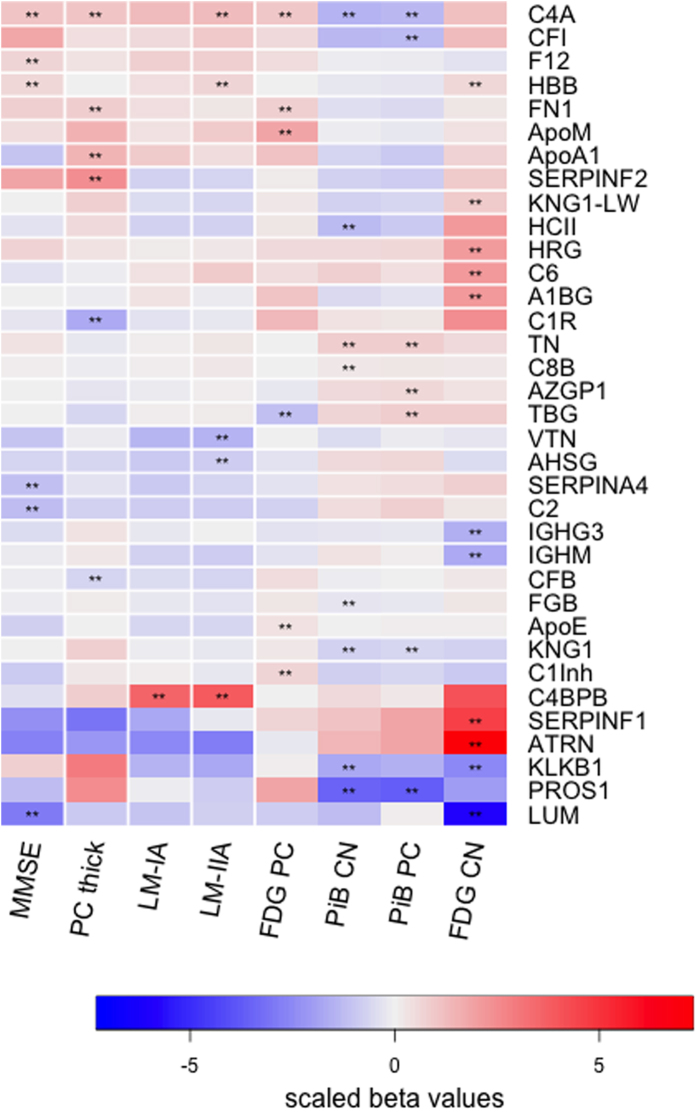
Heat map of proteins associated with cognition and neuroimaging measures.The heat map shows proteins that were significantly associated with at least one of eight outcomes, namely cognitive function represented by MMSE score, episodic memory represented by LM-IA and LM-IIA scores, average precuneus thickness (PC thick), glucose metabolism in the precuneus (FDG PC) and caudate nucleus (FDG CN) and amyloid deposition in the precuneus (PiB PC) and caudate nucleus (PiB CN). Associations marked with ** were found to be significant with a Bonferroni corrected p value of < 0.05/81. Colour represents scaled β values with red indicating positive associations and blue negative associations. The actual values for β coefficients, standard errors and p-values are given in Table S4. A1BG, α-1B-glycoprotein; AHSG, α-2-HS-glycoprotein; ApoA1, Apolipoprotein A-I; ApoE, apolipoprotein E; ApoM, apolipoprotein M; ATRN, attractin; AZGP1, zinc-α-2-glycoprotein; C1R, complement C1r subcomponent; C2, complement C2; C4A, complement C4-A; C4BPB, C4-b binding protein β chain; C6, complement component C6; C8B, complement component C8; CFB, complement factor B; CFI, complement factor I; TN, tetranectin; F12, coagulation factor XII; FGB, fibrinogen β chain; FN1, fibronectin; HBB, haemoglobin subunit β; HRG, histidine-rich glycoprotein; IGHG3, Ig γ-3 chain C region; IGHM, Ig μ chain C region; KNG1, kininogen; KNG1-LW, low molecular weight isoform of kininogen; LUM, lumican; KLKB1, plasma kallikrein; PROS1, Vitamin K-dependent protein S; SERPINA4, kallistatin; TBG, thyroxine-binding globulin; HCII, heparin cofactor II; SERPINF1, pigment epithelium-derived factor; SERPINF2, α-2-antiplasmin; C1Inh, plasma protease C1 inhibitor; VTN, vitronectin. The heat map was generated using the R package gplots.